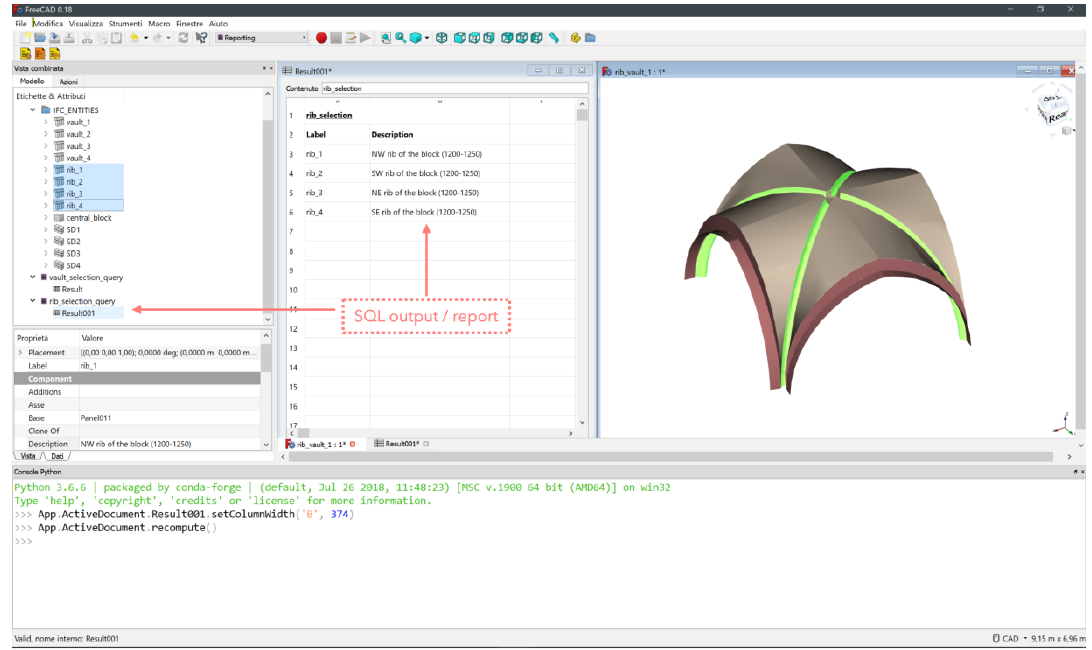
Figure 16. SQL query in order to investigate Rib IFC custom role referred to rib vault and their description: on the left side are the saved rib_selection_query and the related datasheet report with the query result.